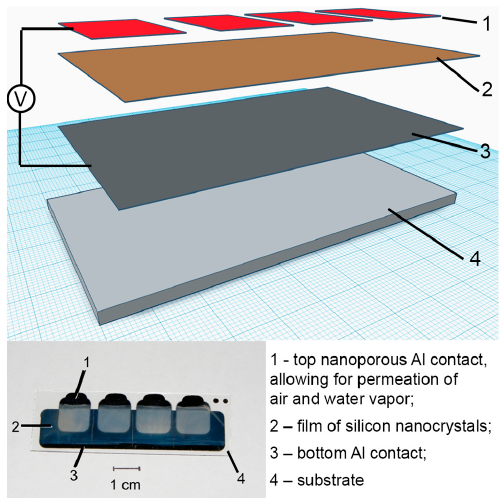
Figure 1. Scheme of Al/nc-Si/Al structure.